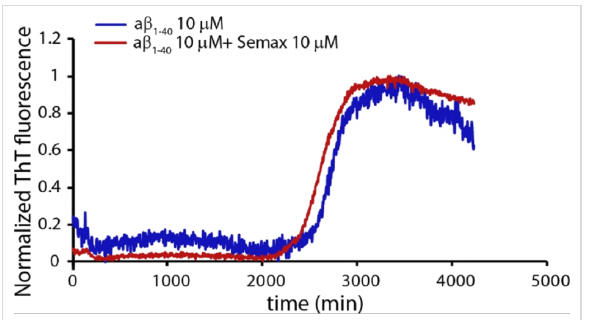
Figure 4: Amyloid fibril growth detected by Th-T fluorescence as a function of the time; 10 µM A β 40 (blue curve), A β 40 in presence of equimolar amount of Semax (red